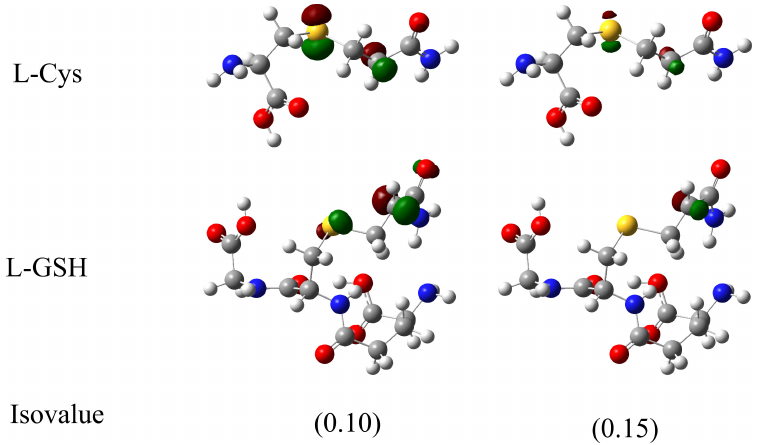
Figure 5. SOMO orbital graphs for modeled transition state free radicals with isovalues of 0.10 and